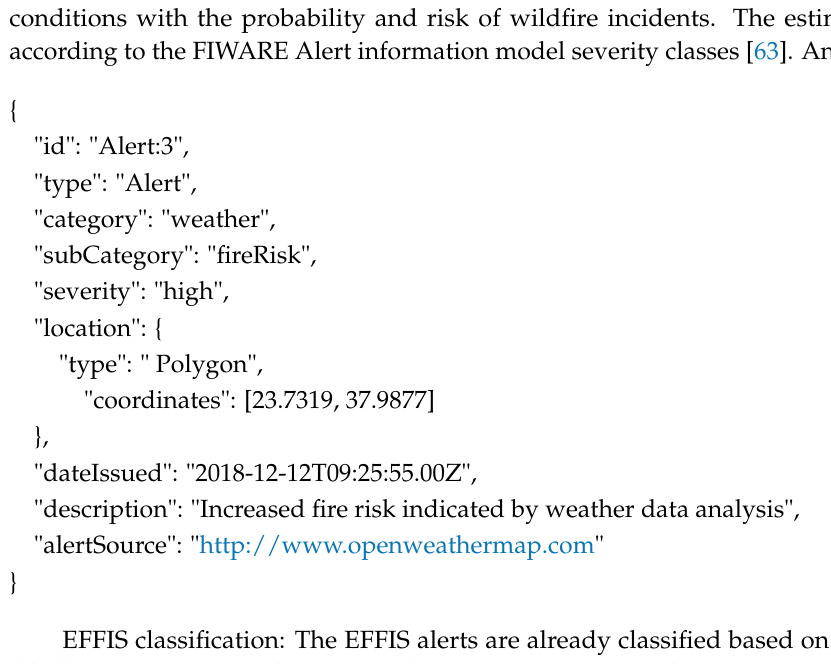
} EFFIS classification: The EFFIS alerts are already classified based on a scale of six levels (http: //effis.jrc.ec.europa.eu/about-effis/technical-background/fire-danger-forecast/) that are directly mapped to the FIWARE Alert information model severity classes